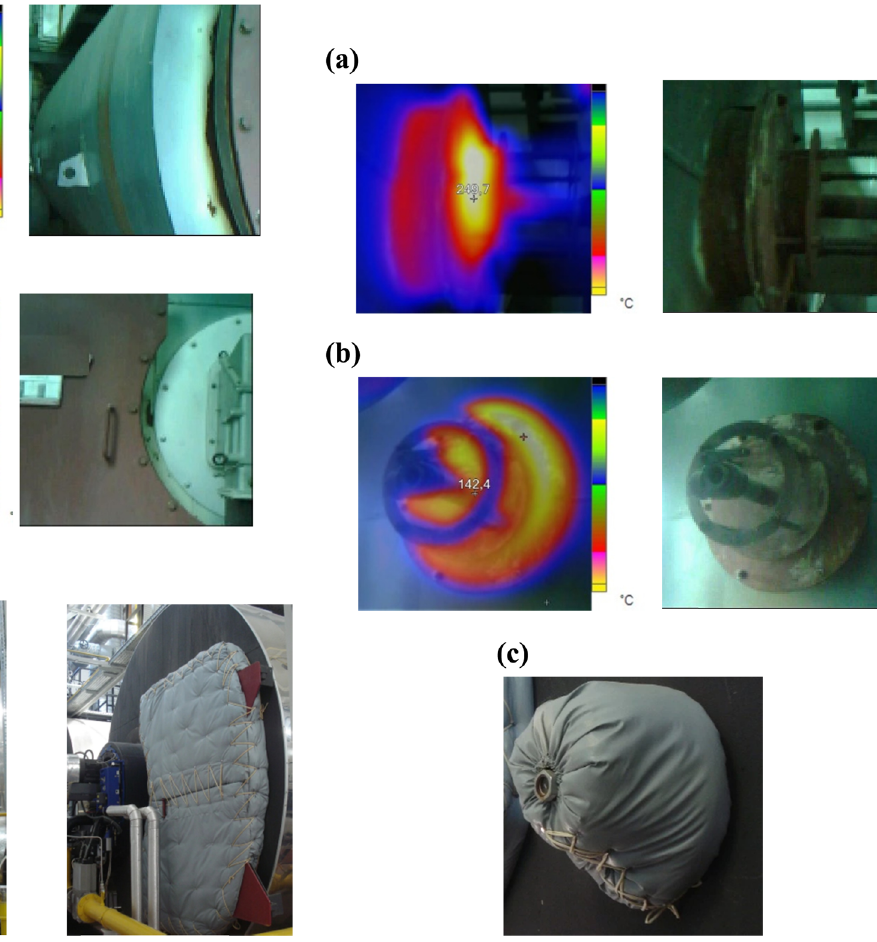
Figure 4: ( a ) Side surface of the front cover ( 219°C ) , ( b ) front surface of the front cover ( 102°C ) , and ( c ) recommended insulation jacket for the front cover.